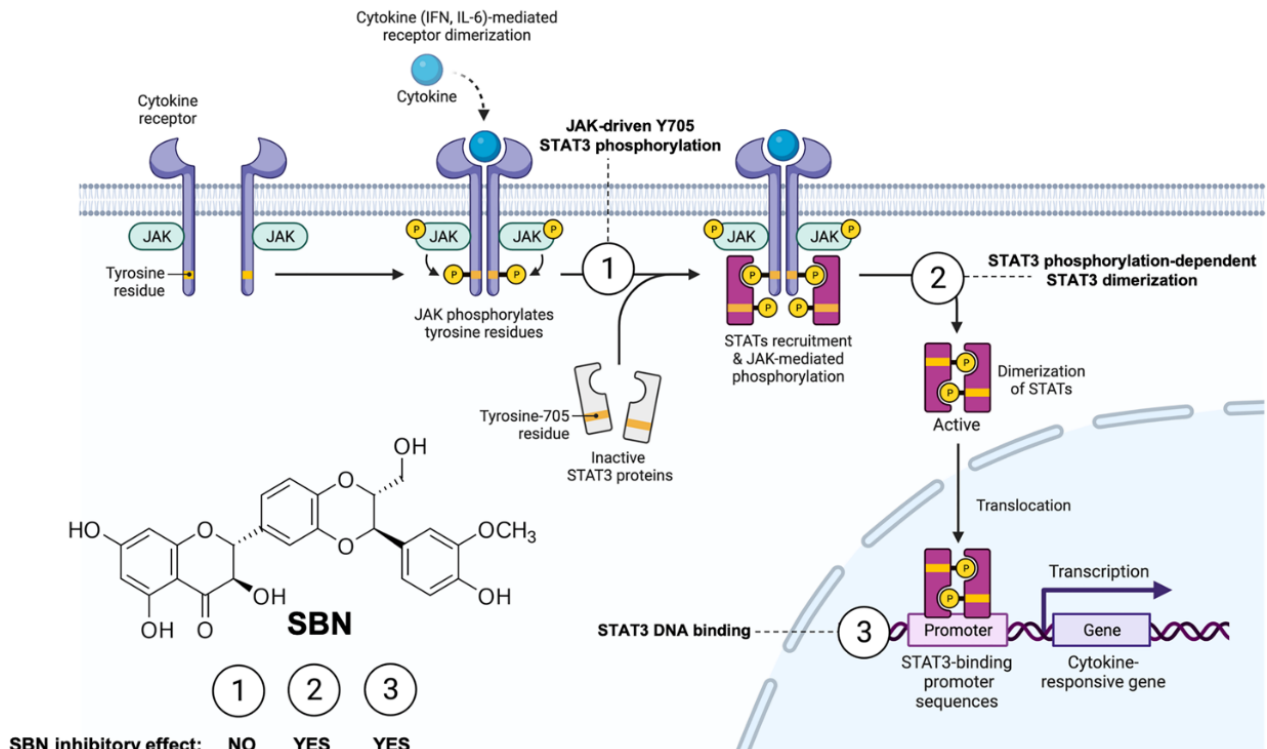
Figure 3. Silibinin: A bimodal STAT3i of the JAK-STAT3 pathway. Silibinin can reduce IL-6 inducible, constitutive, and acquired feedback activation of STAT3 at tyrosine 705 (Y705). A multi- faceted combination of enzymatic assays, computational modeling, and in vitro/in situ validation has delineated the mechanism of action through which silibinin targets STAT3 [23–26]. Silibinin fails to drastically alter the activity of the STAT3 upstream kinases JAK1 and JAK2 (mechanism 1). Silibinin could directly bind to both the Src homology-2 (SH2) domain to indirectly prevent Y705 phosphorylation via a unique binding mode that partially overlap with the cavity occupied by other STAT3 inhibitors (mechanism 2) and the DNA-binding domain (DBD) of STAT3 to block the binding of activated STAT3 to its consensus DNA sequence via a unique mechanism that might involve direct interactions with DNA (mechanism 3). Accordingly, silibinin treatment suffices to reduce phosphor-activation of Y705, prevent STAT3 nuclear translocation, and suppress STAT3-directed transcriptional activity. Created with